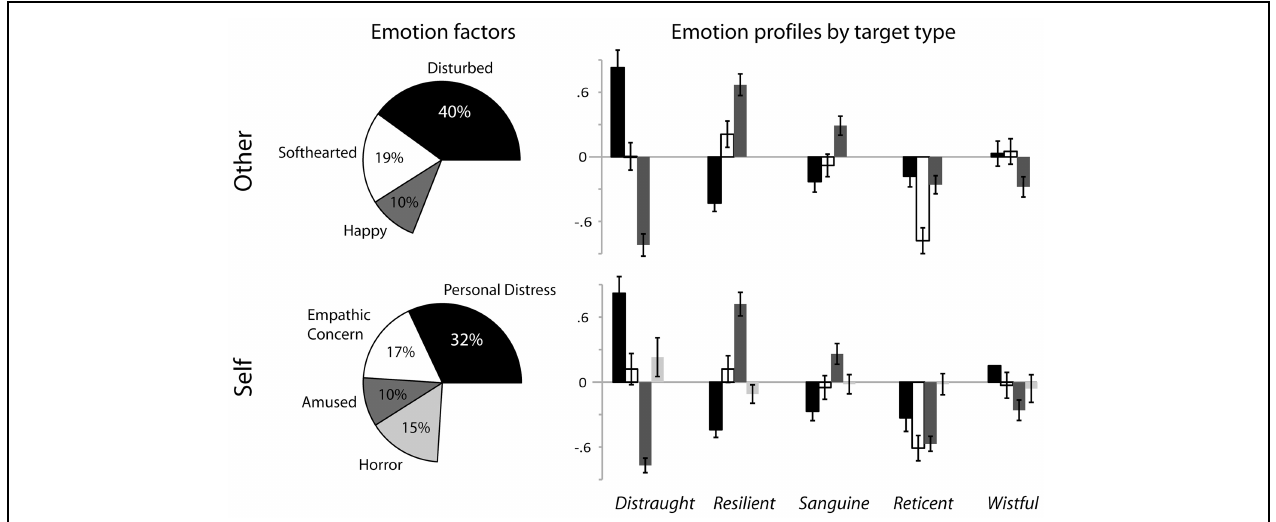
FIGURE 1 | PCA emotion factors were similar between ratings of the other (the targets, represented on the top left) and self (the observers response to the targets, represented on the bottom left). The factor label and percent of variance that it explained is indicated outside of and inside of each pie slice (respectively), with the unexplained variance left out of the pie. Similar factors between other and self are shaded the same (i.e., disturbed and personal distress are black, softhearted and empathic concern are unfilled, happy and amused are dark